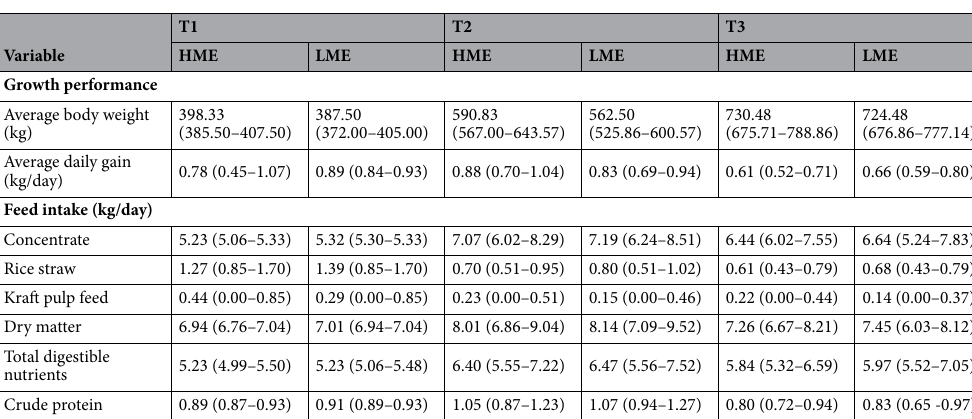
Table 1. Mean growth performance and feed intake in Japanese black cattle during the fattening period. T1: early fattening phase (13 months of age), T2: middle fattening phases (20 months of age), T3: late fattening phases (28 months of age). HME: group of high methane emission cattle (n = 6), LME: group of low methane emission cattle (n = 6); The cattle were fed concentrates as follows: T1: steam-flaked corn 42%, wheat bran 27%, corn gluten meal 10%, soybean meal 12%, soybean hull 6%, salt 1% (TDN 71.2%, CP 15.9%); T2: steam- flacked corn 42%, barley 14%, wheat bran 21%, corn gluten meal 5%, soybean meal 10%, soybean hull 6%, salt 1% (TDN 72.5%, CP 14.4%); T3: steam-flacked corn 44%, barley 25%, wheat bran 14%, soybean meal 5%, soybean hull 10%, salt 1% (TDN 72.8%, CP 12.0%). The rice straw intakes were as follows: DM 87.8%, TDN 37.7%, CP 4.7%. The kraft pulp feed intakes were as follows: DM 76.9%, TDN 51.1%, CP